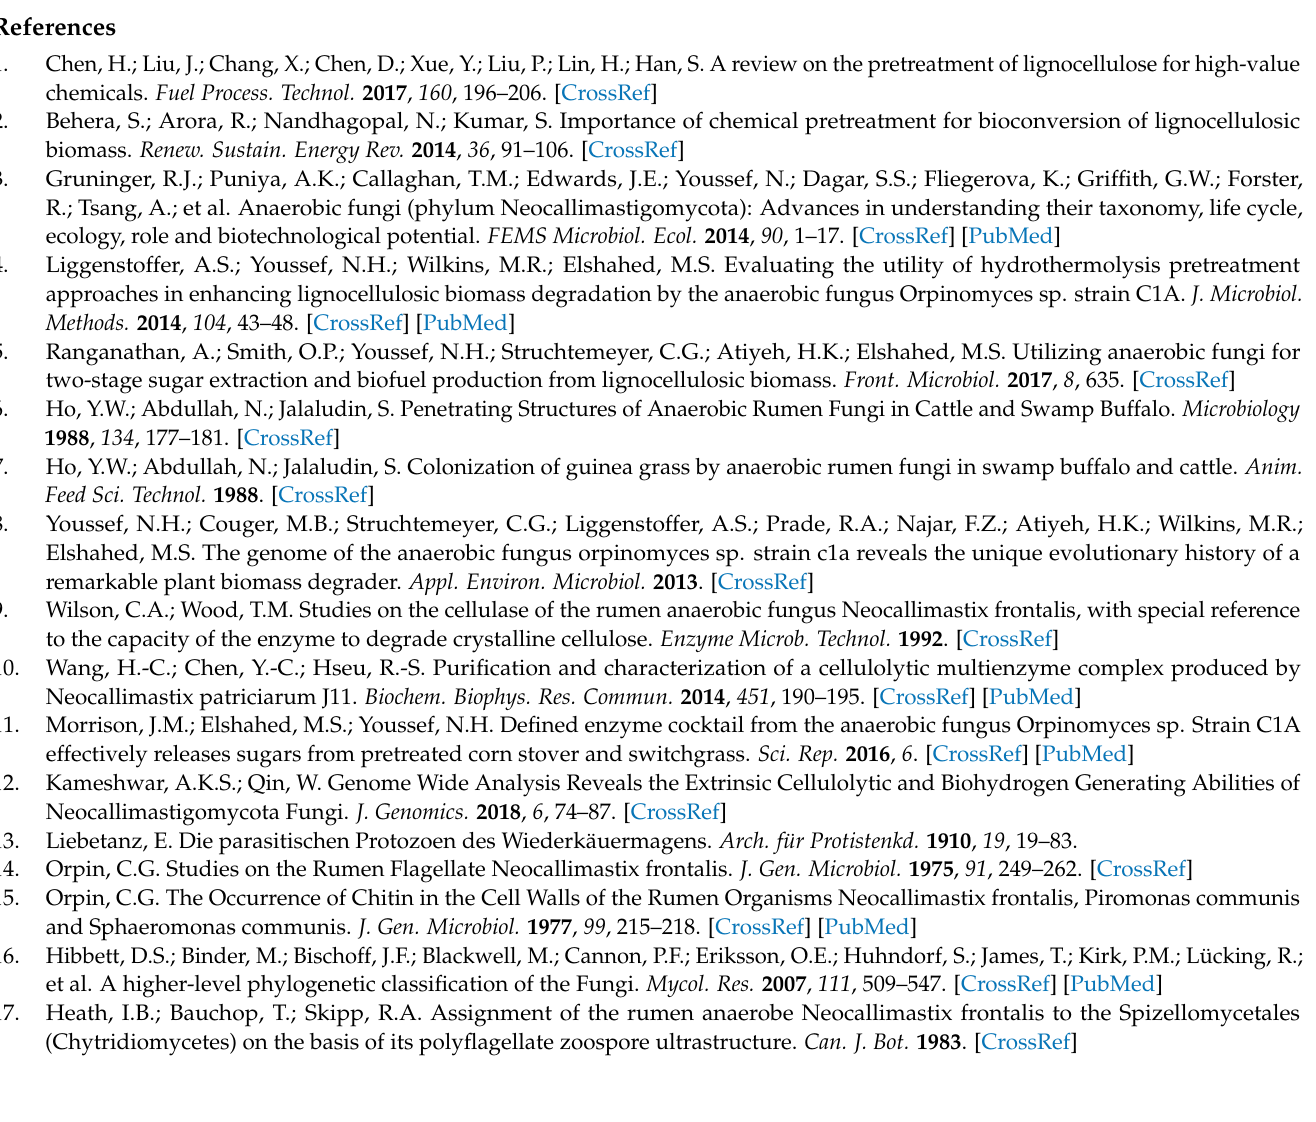
Table S12: Produced metabolites from X2152; Table S13: Relative produced metabolites from X2152; Table S14: Produced metabolites from A252; Table S15: Relative produced metabolites from